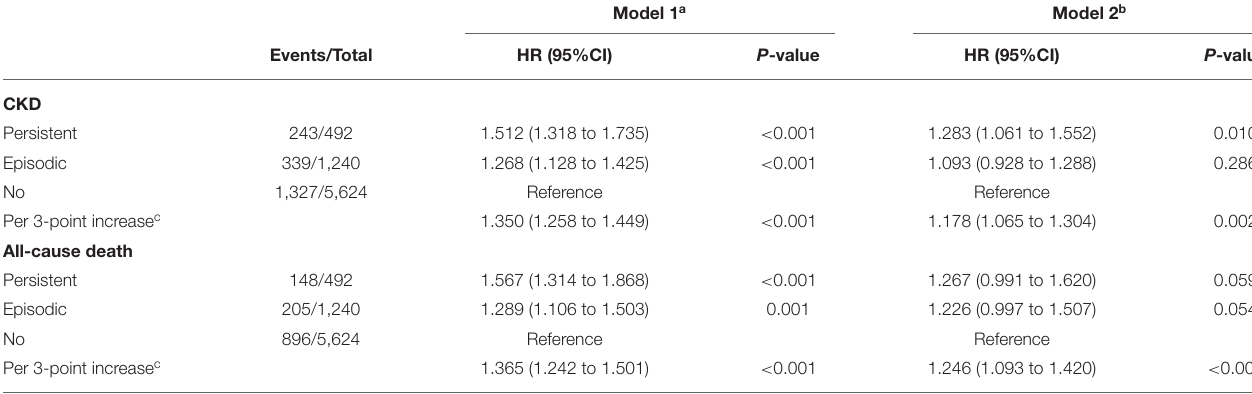
TABLE 3 | Association between baseline depressive symptoms and risk of incident CKD and all-cause